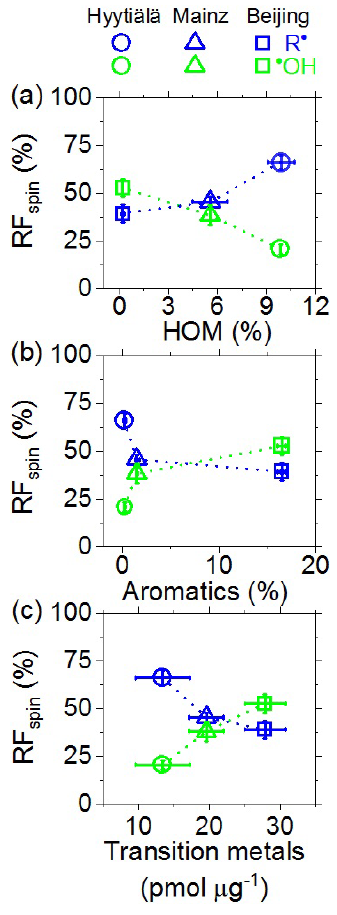
Figure 4. Relative fractions (RF spin ) of aqueous-phase C-centered (cid:113) (cid:113) (R ) and OH radicals plotted against the relative abundances of (a) highly oxygenated organic molecules (HOM), (b) aromatics, and (c) water-soluble transition metals in ambient PM 2 . 5 from Hyytiälä, Mainz, and Beijing. The relative abundances of HOM and aromatics in (a) – (b) represent the summed chromatographic area of HOM or aromatics divided by the summed chromatographic area of all assigned organic compounds. The abundances of HOM shown in (a) were taken from a recent companion study (Tong et al., 2019). The error bars represent standard errors of the mean (4–12 samples per location). The dashed lines are included to guide the